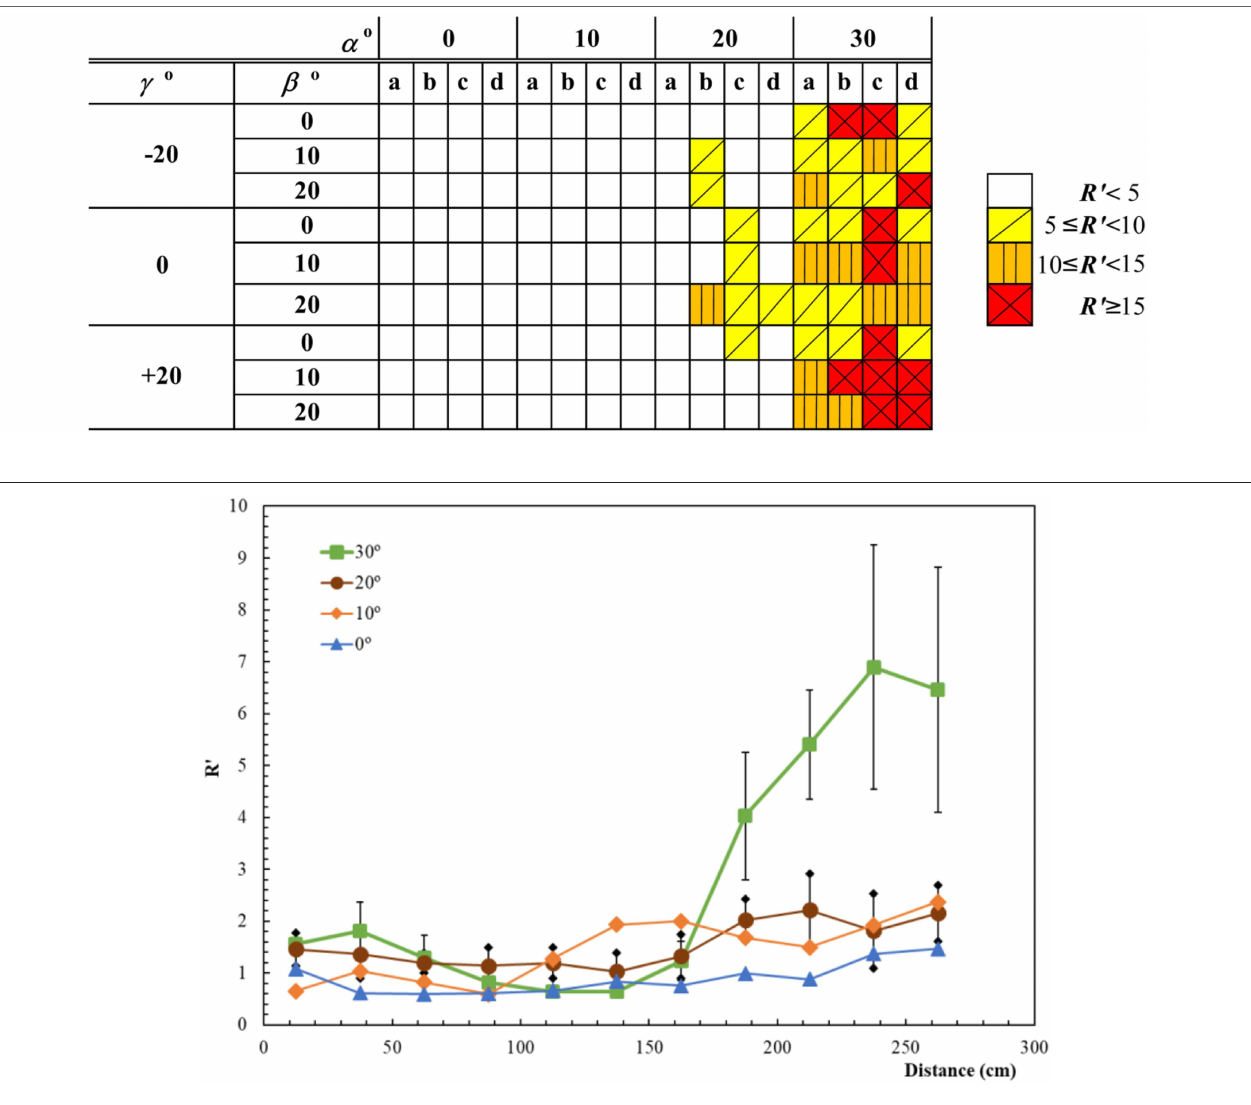
FIGURE 6 | Mean values of R’ along line b for tests with β = 0 ◦ and γ = − 20 ◦ for various of slope angle α . The error bars correspond to a level of confidence of